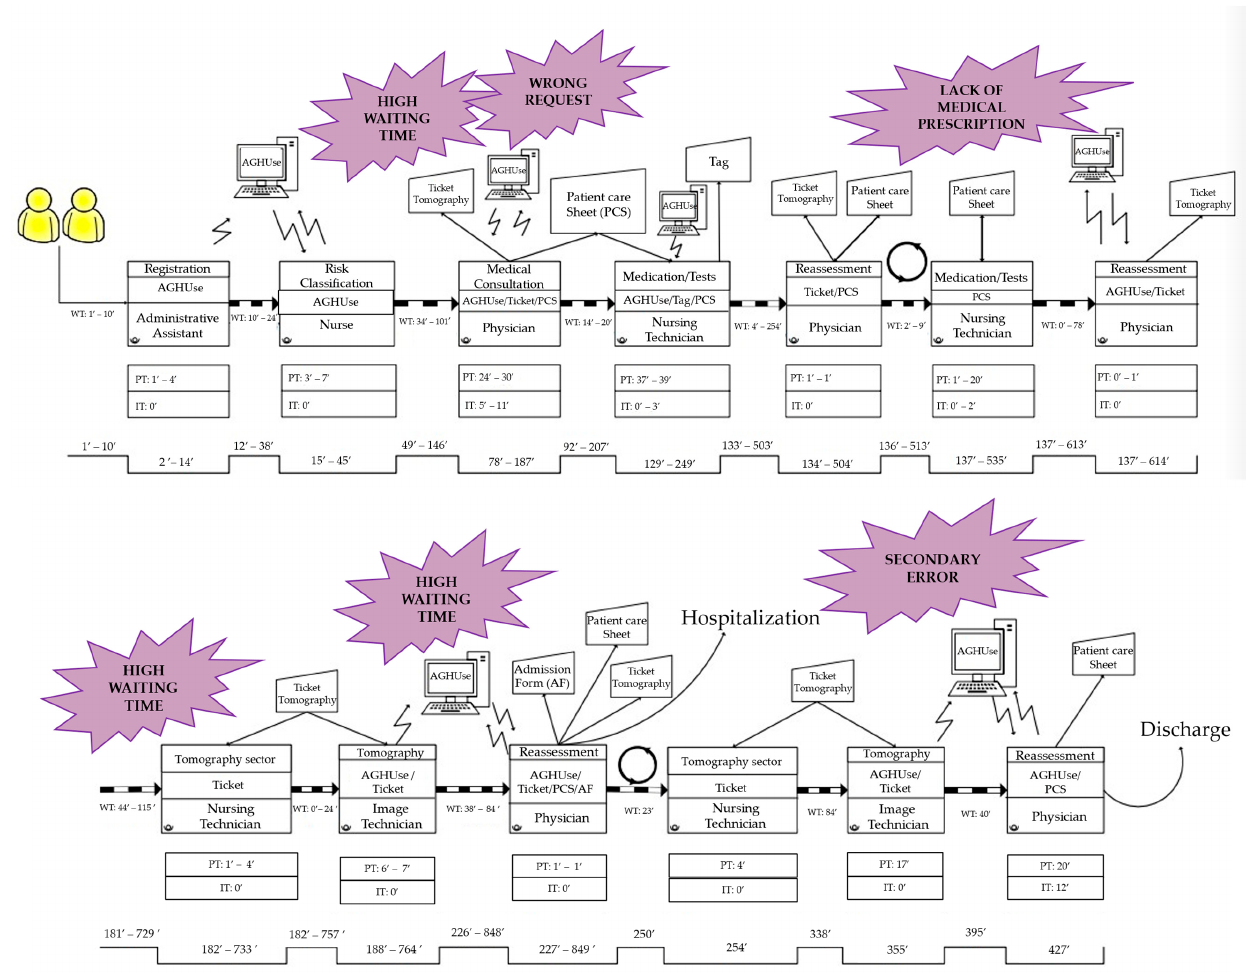
Figure 1. Value Stream Map of patients who required tomography ( n = 2).